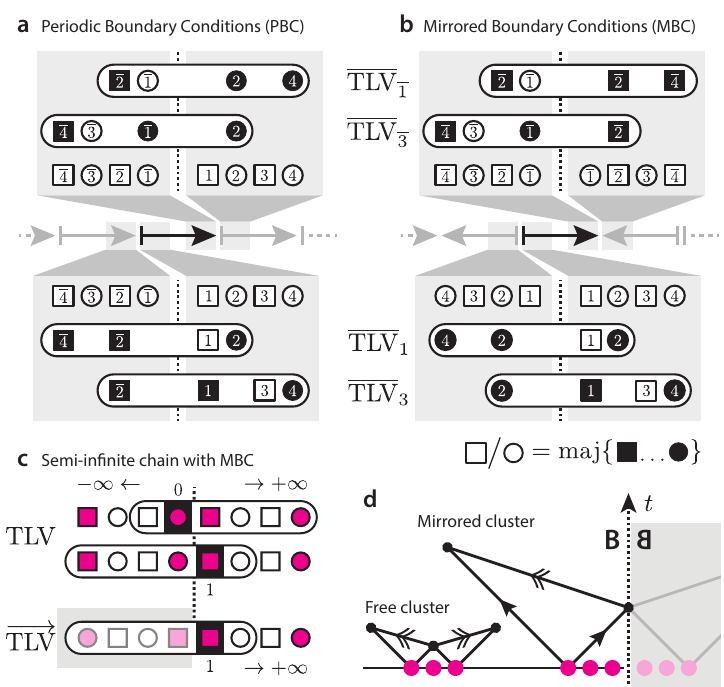
Figure 4: Boundary conditions. a Periodic boundary conditions (PBC). A finite system of length L (black arrow) is copied and chained without inverting the direction. Four local rules tra- verse the boundary and are modified accordingly. b Mirrored boundary conditions